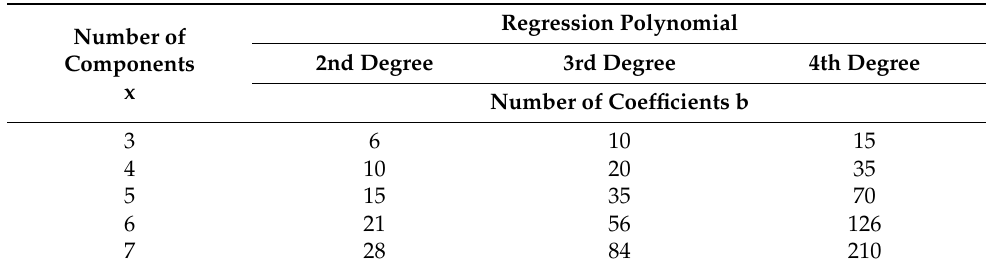
Table 1. Number of coefficients b of a regression polynomial in relation to the degree of the polyno- mial and the number of components